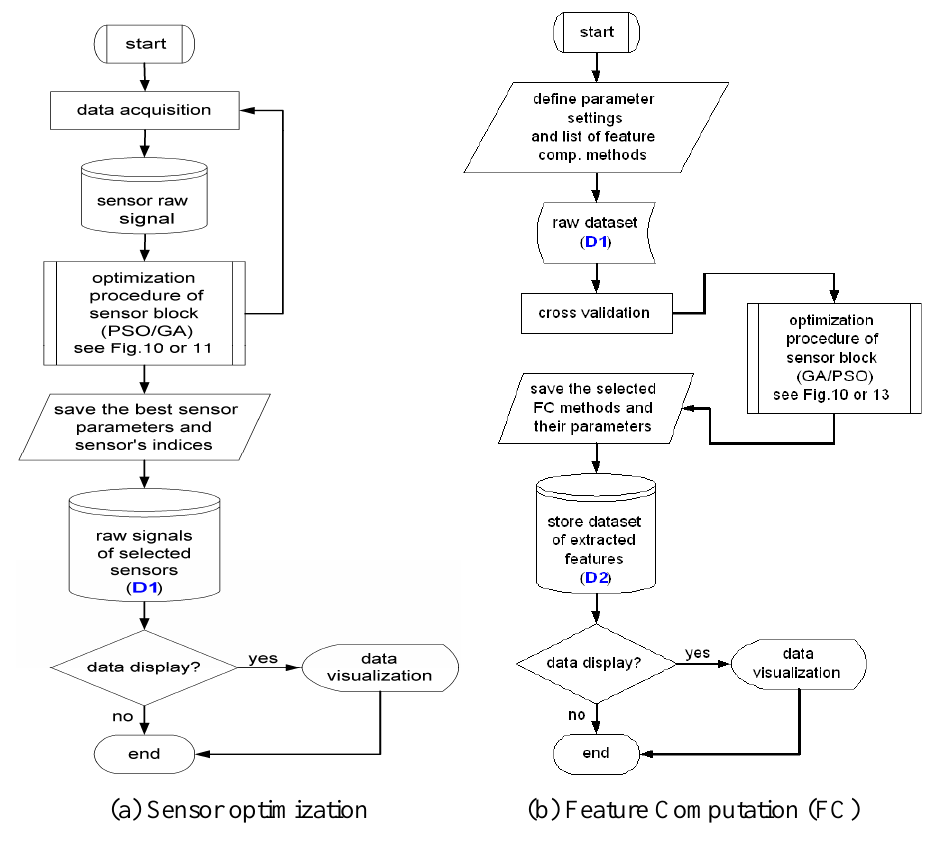
Figure 9. The local optimization procedures in